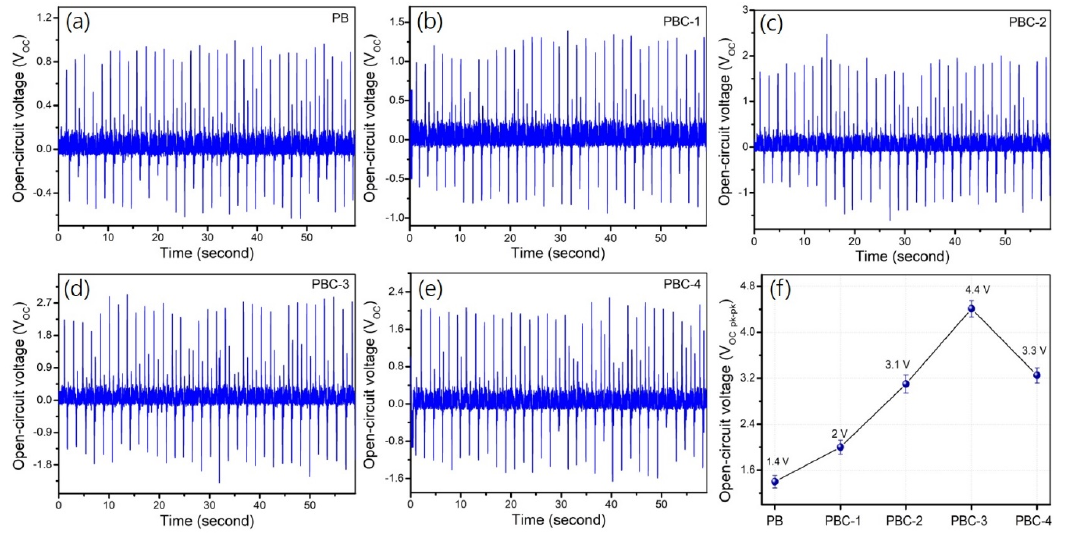
Figure 7. Open ‐ circuit voltage of PB and PBC films: ( a ) PB; ( b ) PBC–1 ; ( c ) PBC–2; ( d ) PBC–3; ( e ) Figure 7. Open-circuit voltage of PB and PBC films: ( a ) PB; ( b ) PBC–1; ( c ) PBC–2; ( d ) PBC–3; ( e ) PBC–4; PBC–4; and ( f ) overall peak ‐ to ‐ peak output voltage. and ( f ) overall peak-to-peak output